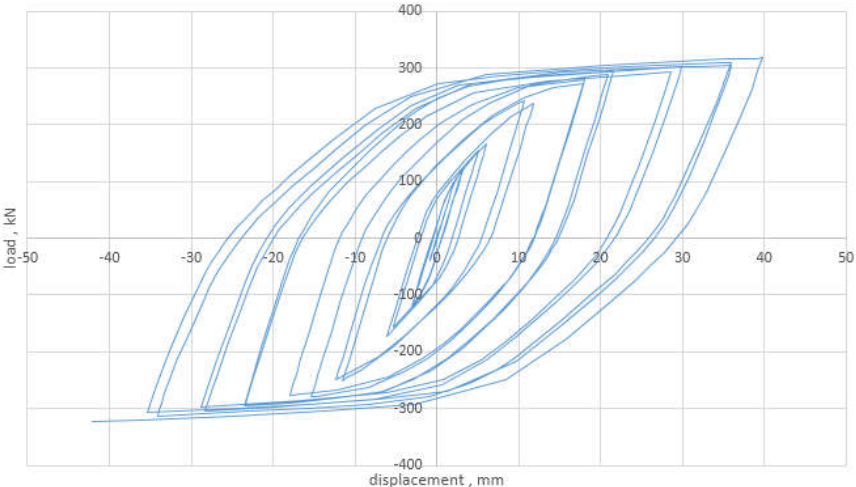
Figure 26. The hysteresis diagram due to loading on the frame.